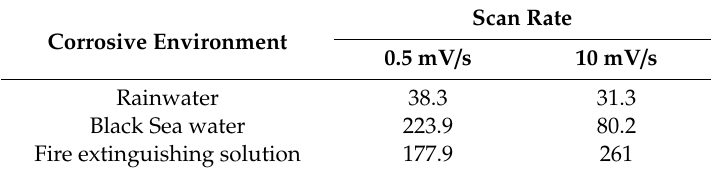
Table 6. Comparison between corrosion rates (v cor -in µ m / year) for the C45 sample.